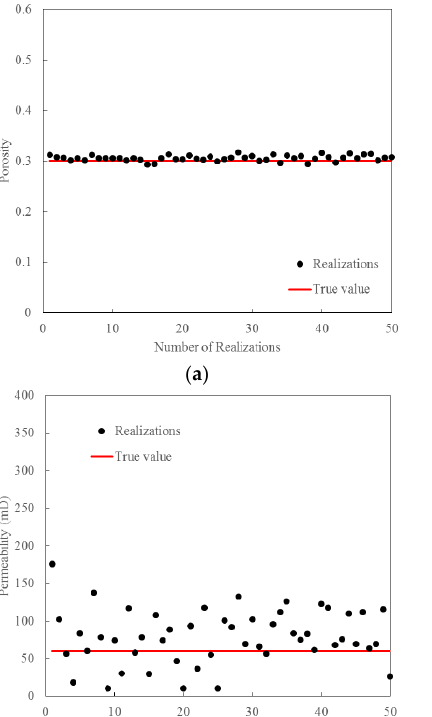
Figure 11. The parameter values after history matching: ( a ) Porosity; ( b ) Permeability in layer 1; ( c ) Permeability in layer 2; ( d ) Permeability in layer 3.